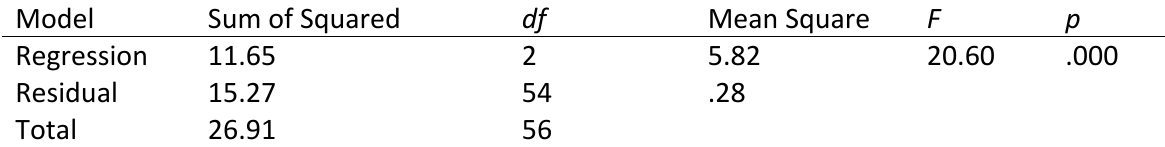
Analysis of Variance in Support for Farmers’ Quality of Life Model